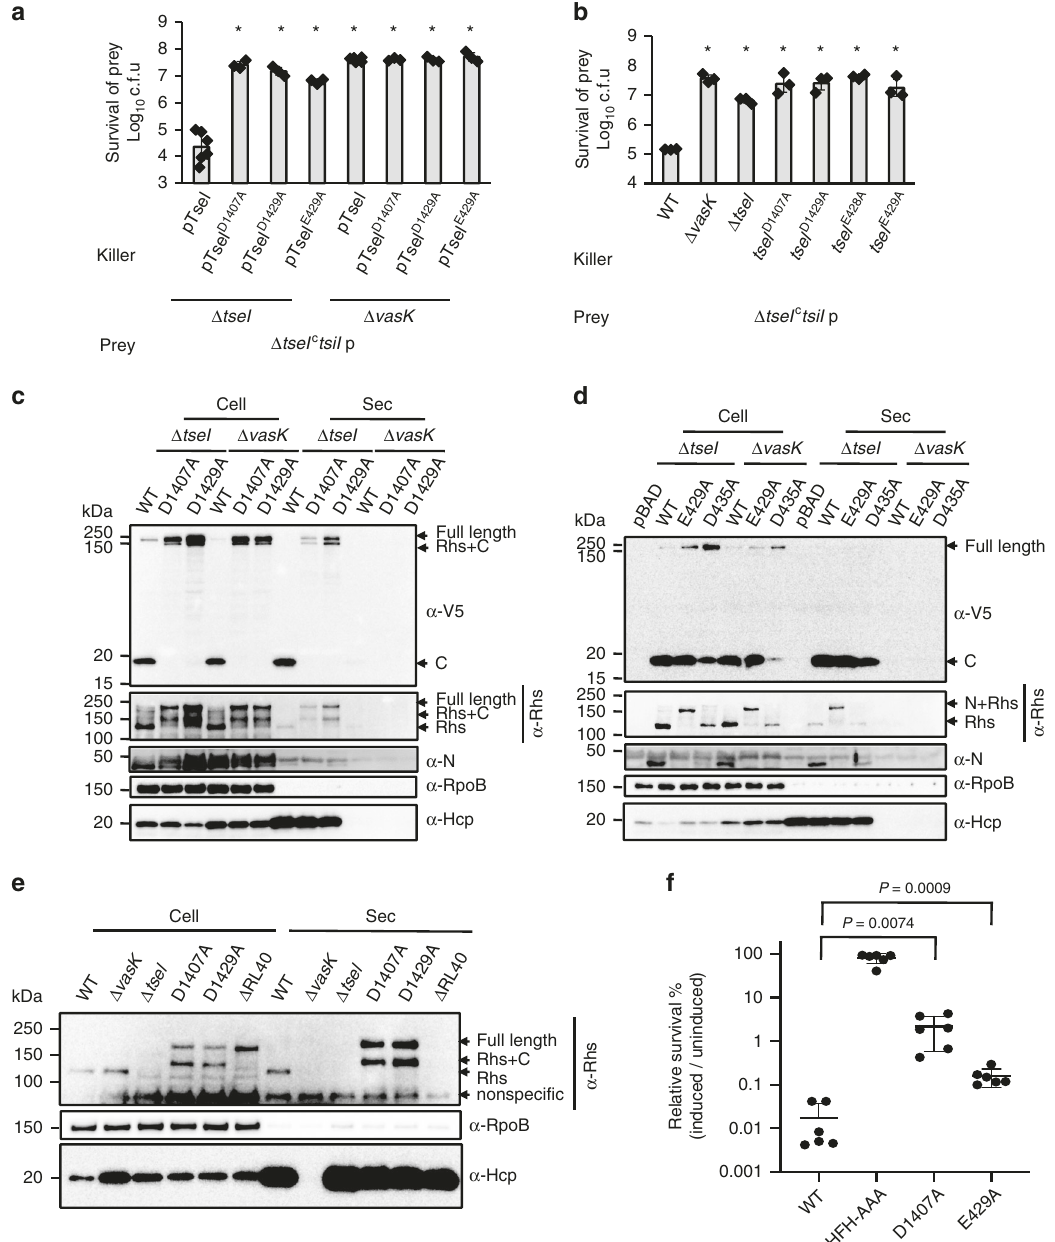
Fig. 3 Effects of self-cleavage on TseI functions. a Competition analysis of the Δ tseI mutant complemented with different TseI cleavage mutants. Killer strains expressing pBAD-TseI constructs are indicated and the prey strain is the Δ tseI c tsiI mutant. The Δ vasK mutant serves as a T6SS-null control. b Competition analysis of chromosomal tseI mutants against the Δ tseI c tsiI prey. For a and b , error bars indicate the mean ± standard deviation of at least three biological replicates ( n = 6 for Δ tseI and Δ vasK carrying pTseI plasmid as killer, and n = 3 for the others) and statistical signi fi cance was calculated using a two-tailed Student ’ s t -test, * P < 0.01. c Secretion analysis of TseI C-terminal cleavage-defective mutants. d Secretion analysis of TseI N-terminal cleavage-defective mutants. For c and d , the Δ tseI mutant and the Δ vasK mutant hosting pBAD vectors expressing C-terminal 3V5-tagged proteins were induced with 0.01% arabinose. Protein expression and secretion was detected by western blotting analysis using antiserum to V5 for the C-terminus and full length and custom antisera for the middle Rhs fragment and the N terminus. e Secretion analysis of chromosomal mutants of TseI. The Δ RL40 mutant lacks the protease sequence from arginine 1394 to leucine 1433. TseI was detected using the antibody to Rhs. f Survival of E. coli expressing plasmid-borne wild-type TseI and its cleavage-defective mutants. All TseI proteins were cloned on pBAD vectors. Cells were treated with 0.2% glucose (repression) or induced with 0.01% arabinose for 2 h, after which E. coli cells were 10-fold serial diluted and plated on LB media containing 0.2% glucose to repress expression. Relative survival was calculated as the percentage of survived E. coli under induction versus repression conditions. Error bars indicate the mean ± standard deviation of six biological replicates. Statistical signi fi cance was calculated using a two-tailed Student ’ s t -test. The RNA polymerase subunit RpoB serves as a control for cytosolic expression and cell lysis, and the T6SS inner tube Hcp serves as a positive control for T6SS delivery in c , d and e . Source data are provided as a Source Data fi le. Data in a – f are representative of at least two